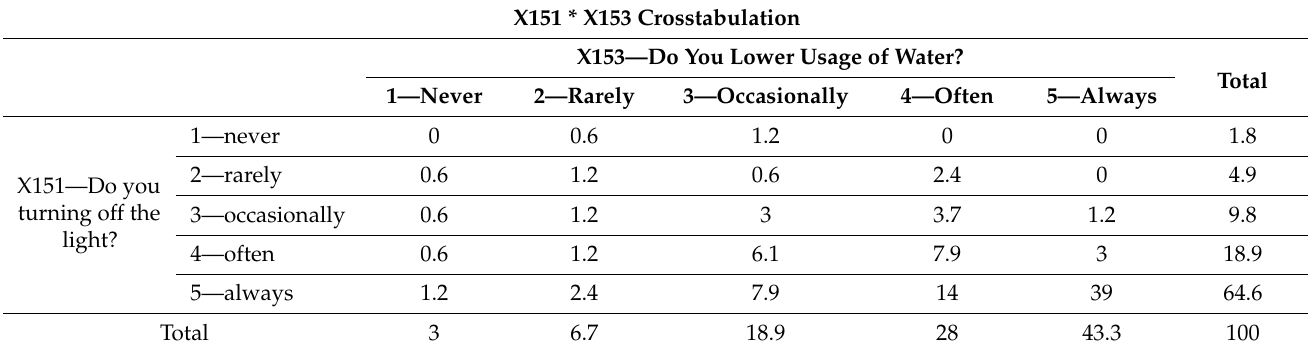
Figure 7. Importance of the benefits associated with an electric drive for microentrepreneur (N = 164). Table 6. Relationship between light off (X151) and turning off water (X153) (N = 164,